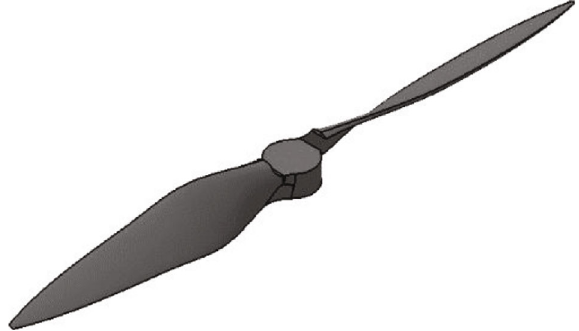
Figure 1: Propeller